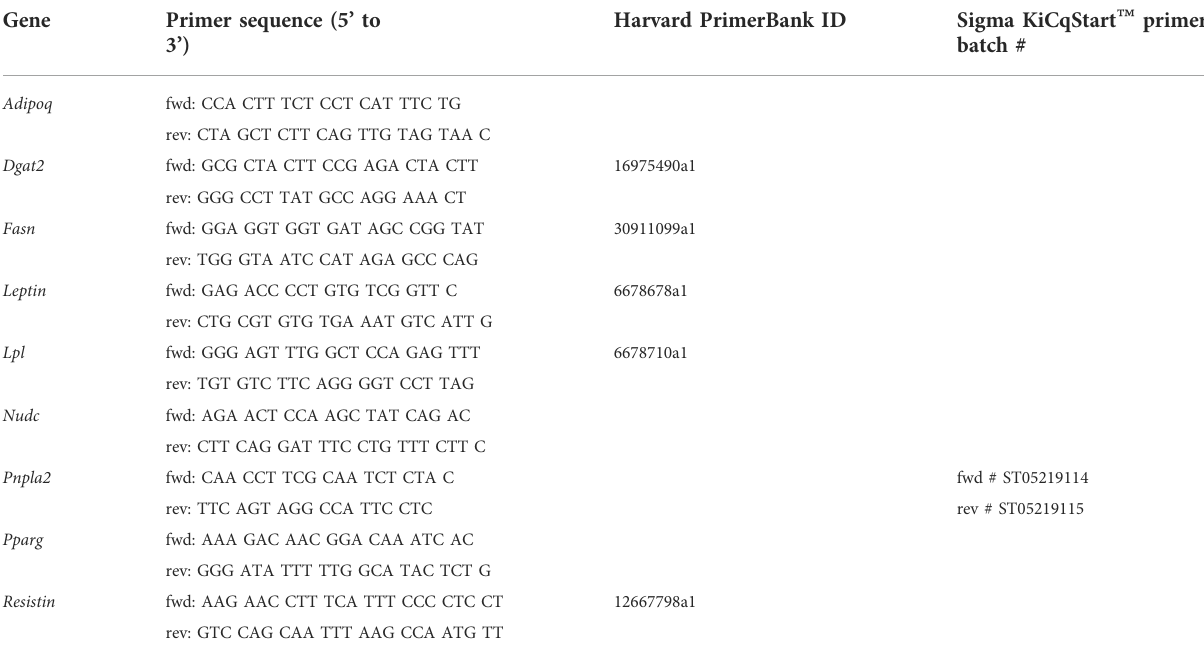
TABLE 1 Primer sequences used for